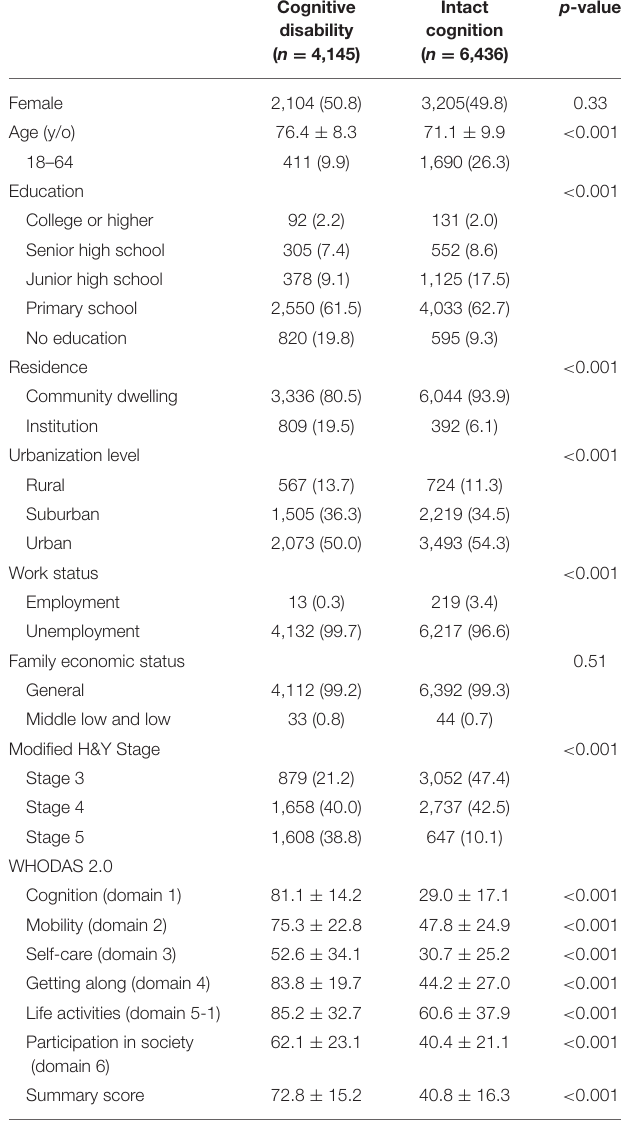
TABLE 1 | Demographic data of all the study